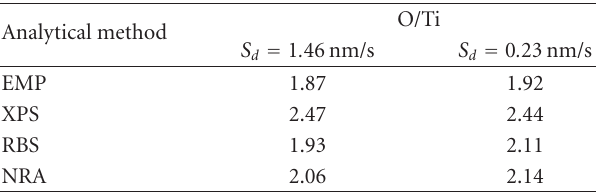
Table 5: Atomic ratio O/Ti determined by four di ff erent analytical methods described in this work for TiO 2 − y thin films obtained under controllable conditions; electron microprobe EMP was per- formed with X-ray microanalyzer ARL SEMQ at beam parameters: 10kV and 0.5 μ A; beam diameter on the sample 5 μ